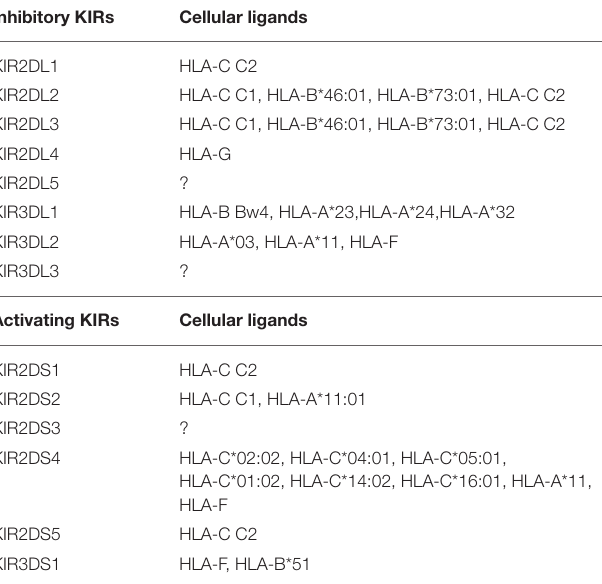
TABLE 1 | Killer cell immunoglobulin-like receptors (KIRs) and their cellular